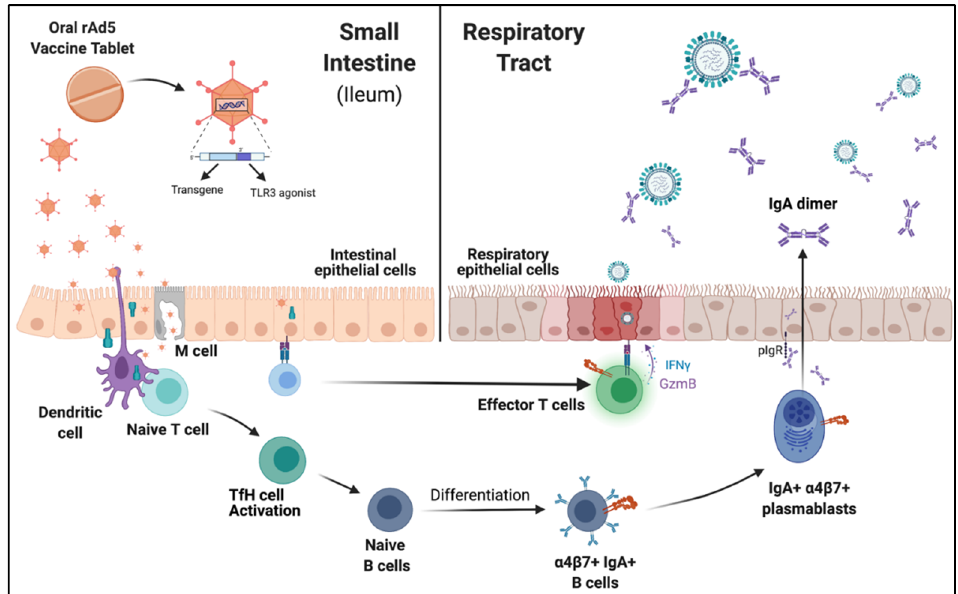
Figure 2. Working model of oral rAd5 vaccine tablet, illustrating how antigen delivery to the small intestine generates protective mucosal immune responses. The non-replicating rAd5 vector contains both the vaccine antigen transgene and the molecular TLR3 adjuvant, which are delivered together to epithelial and resident immune cells. Once released in the gut ileum, the tablet’s enteric coating dissolves and releases rAd5 into the lumen. Following translation of the transgene, the vaccine protein antigen can be displayed on target cells in native confirmation or cross-presented to T cells as peptides on MHC I and II. Constantly sampling the intestinal lumen are other antigen-presenting immune cells, such as dendritic cells (DCs), that can display non-self antigens to naïve T cells and drive T follicular (TfH) expansion. TfH cells provide co-stimulation that enhances B cell differentiation, maturation, and class-switch recombination to IgA-expressing activated B cells. Activated B cells mature into IgA-secreting plasmablasts and enter the lymph and blood, where they traffic to lymphoid tissues and mucosal sites. Following oral vaccination, circulating IgA antibody-secreting cells upregulate the mucosal homing marker α 4 β 7+, traffic to the respiratory tract, and secrete IgA. IgA transcytosis through the epithelial layer is mediated by the polymeric Ig receptor (pIgR) and released into the airway. Resident T cells may also recognize vaccine antigens displayed on the surface of gut epithelial cells or dendritic cells and elicit effector T cell maturation. These effector T cells can provide additional mucosal protection by identifying naturally infected cells and releasing effector molecules, such as IFN γ and granzyme (GzmB), in response to